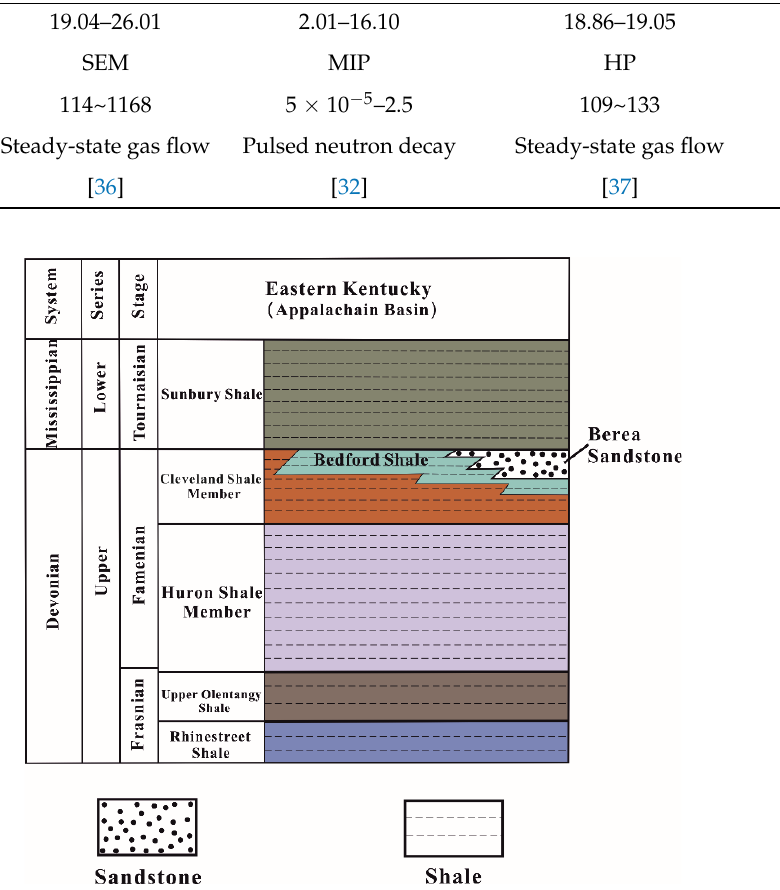
Figure 2. Upper Devonian and Lower Mississippian stratigraphy sequence in eastern Kentucky.